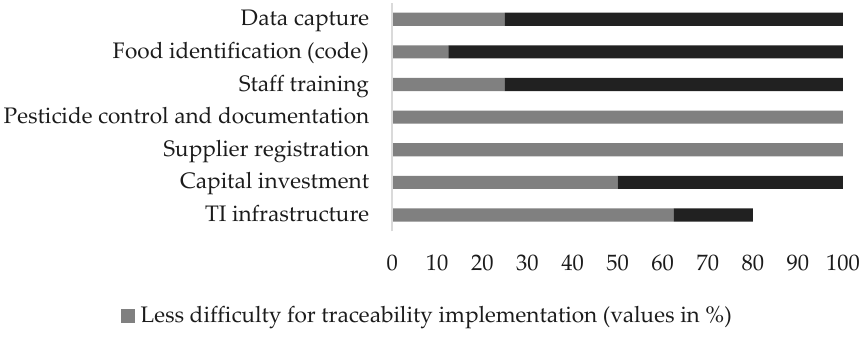
Figure 2. Degree of difficulty of traceability system implementation.